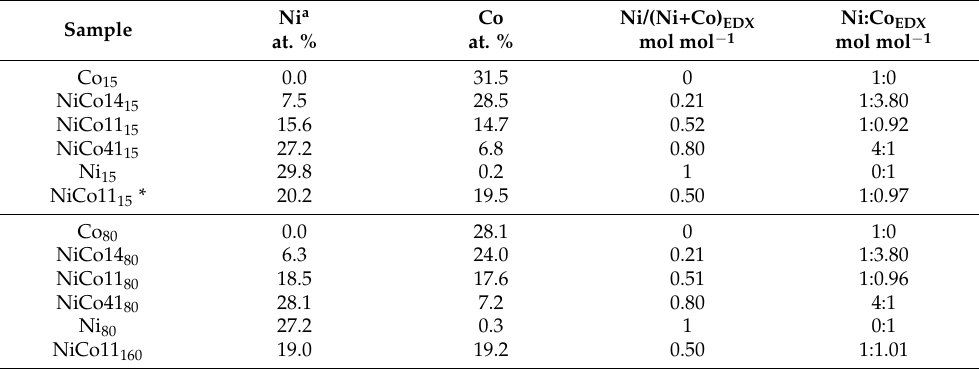
a Ni average atomic concentration in the respective catalysts (correction factor applied) (at%); NiCo11